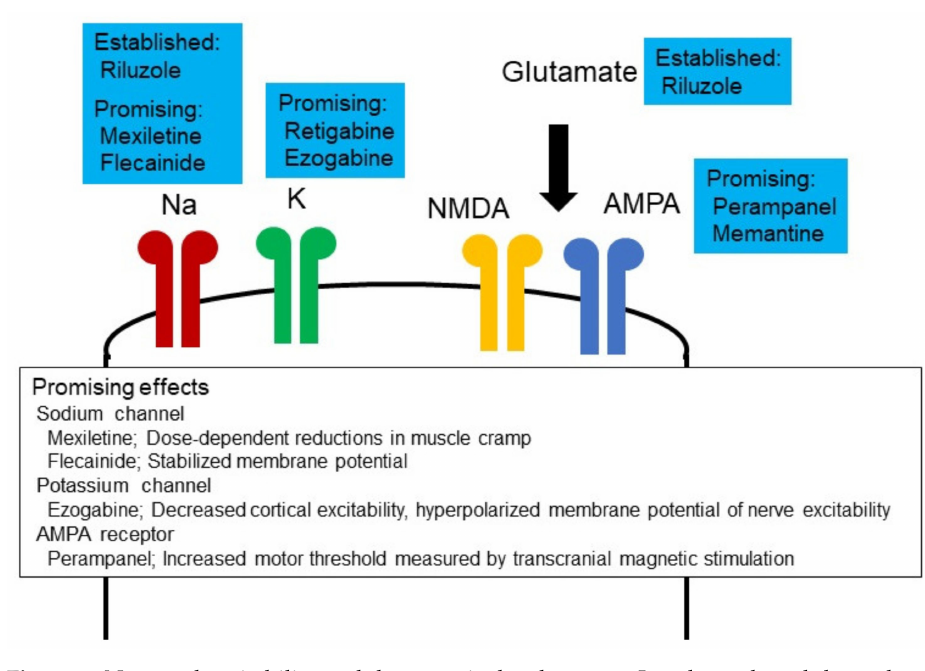
Figure 2. Neuronal excitability and therapeutic development. Ion channel modulators have been investigated for efficacy in ALS. Riluzole inhibits glutamate release, enhances glutamate uptake, blocks voltage-dependent sodium channels, antagonizes NMDA receptors and inhibits GABA uptake. Perampanel exerts effects via AMPA receptors, retigabine and ezogabine through potassium channels and mexiletine and flecainide via sodium channels (see text for clinical trial results). These ion channel modulators showed several lines of